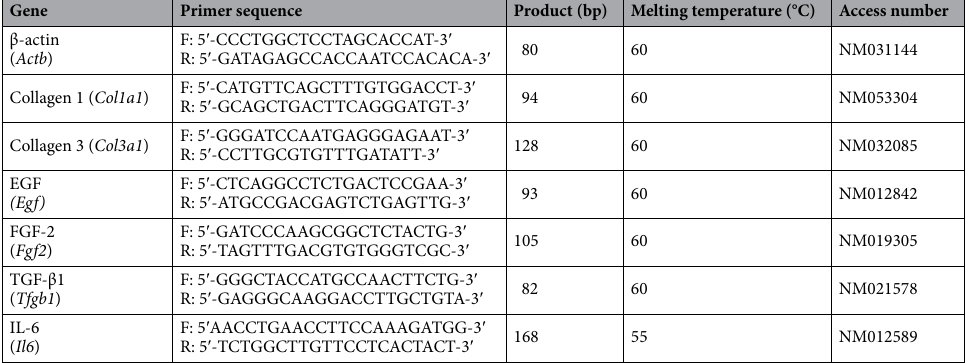
Table 1. Primers used in qPCR. EGF epidermal growth factor; TGF-β1 transforming growth factor beta 1; IL-6 Interleukin-6; F forward; R